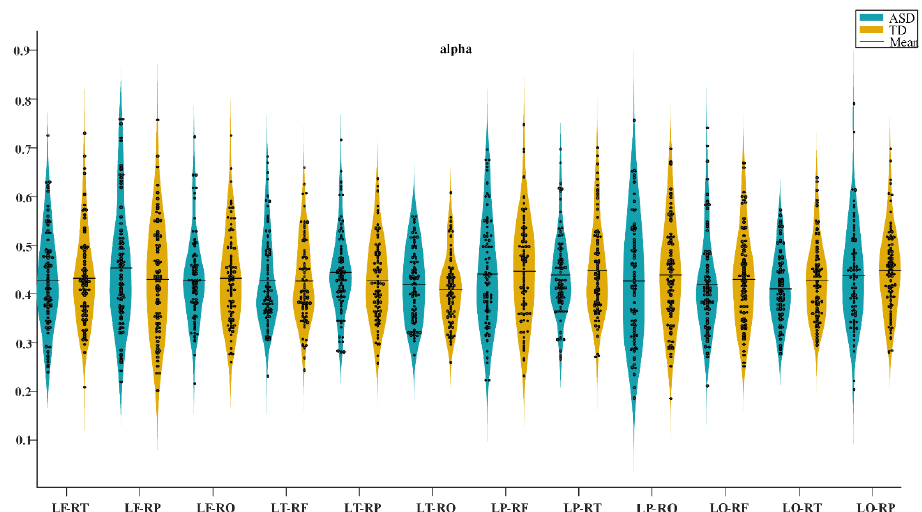
Figure 3. The functional connectivity differences in transhemispheric brain regions of the alpha band between autism spectrum disorder (ASD) and typically developing (TD) groups.